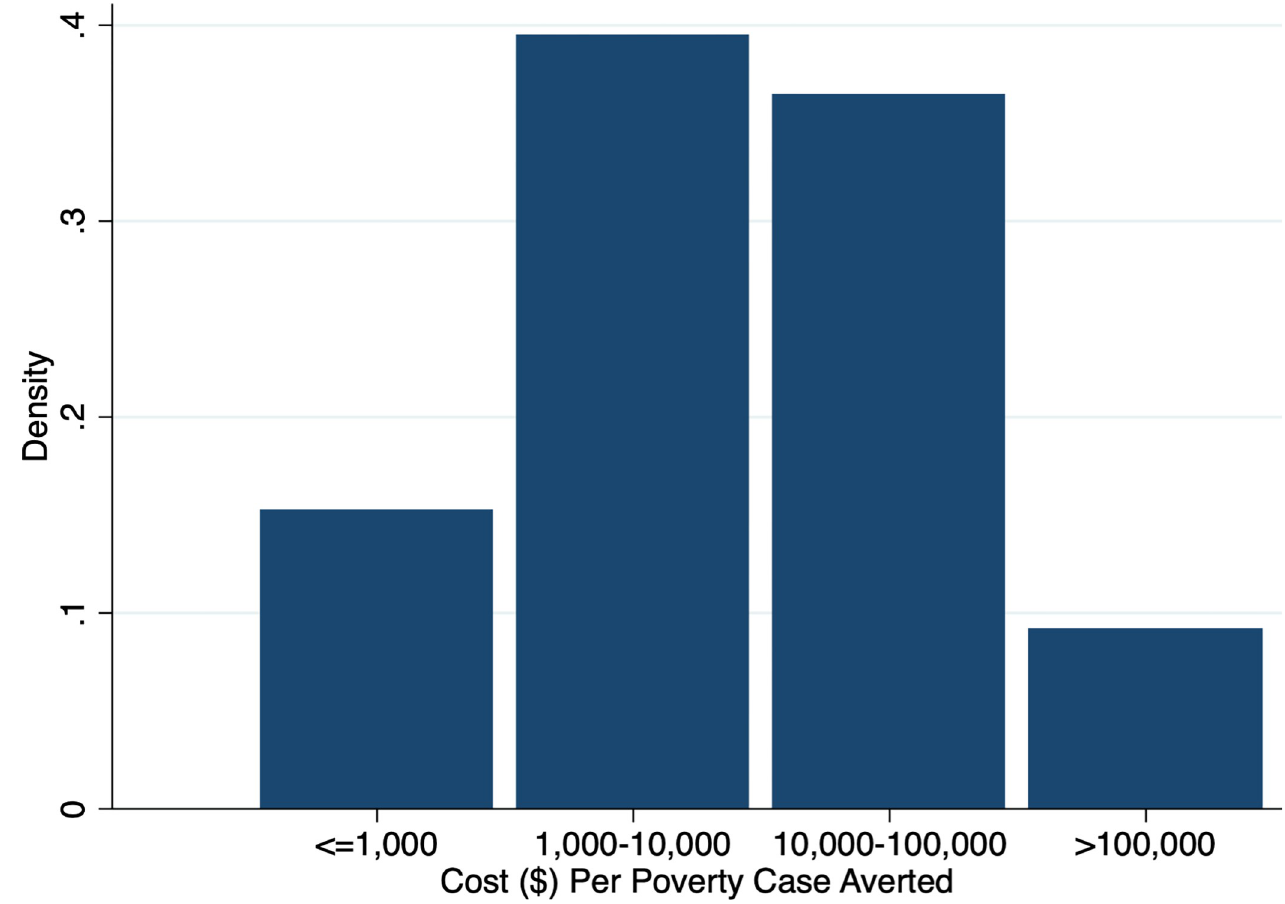
Fig 1. Distribution in estimated costs ($) per poverty case averted across countries using social protection program data. Notes: Source: The World Bank Atlas of Social Protection Indicators of Resilience and Equity (ASPIRE). Sample includes low-income and lower-middle-income countries.